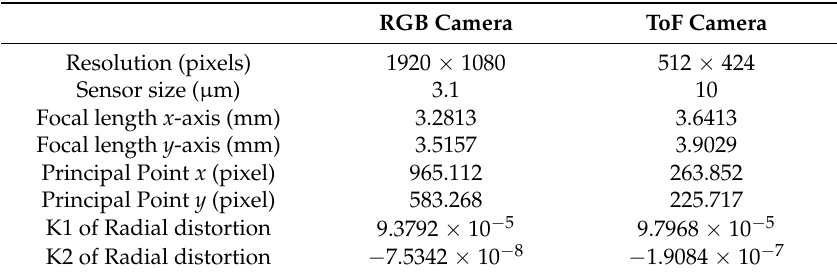
Table 1. Kinect camera intrinsic parameters: the resolution and sensor size information from [36], other parameters obtained via